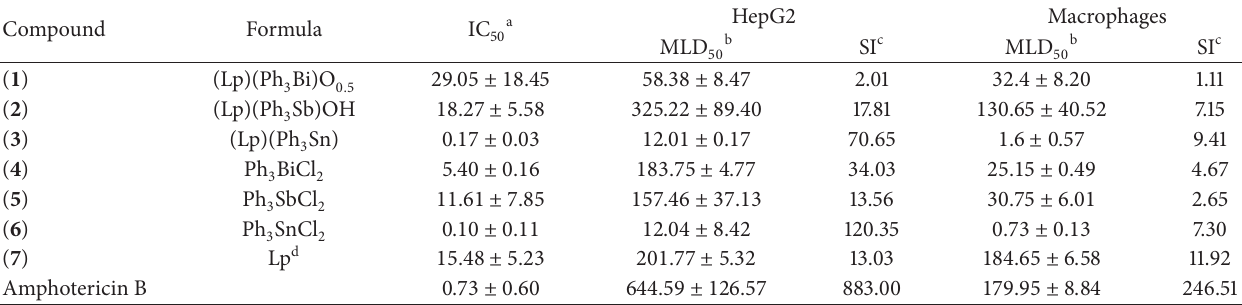
Table 2: Antileishmanial activity, cytotoxicity, and selective indexes of tested compounds for HepG2 cells and murine macrophages.